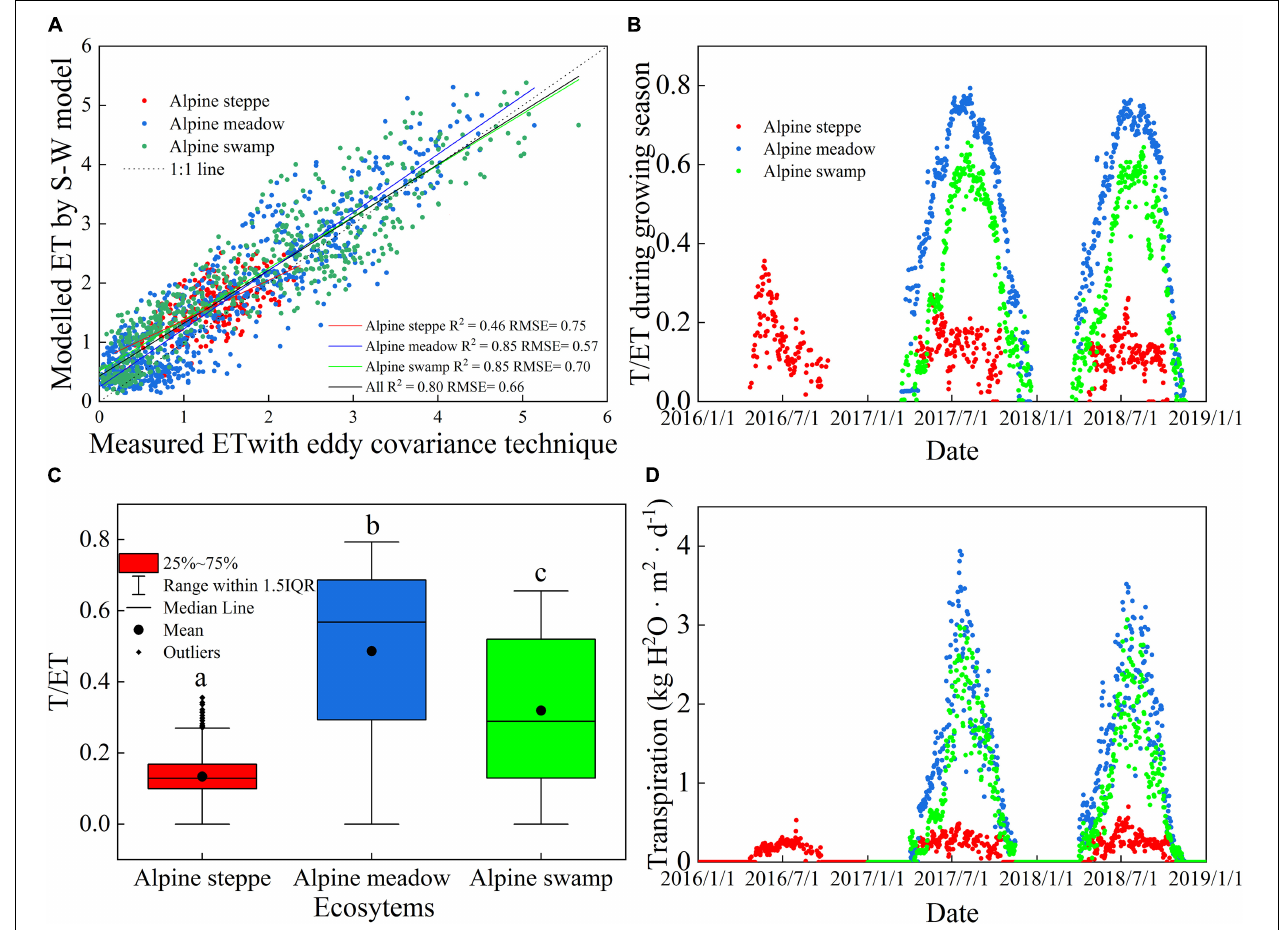
FIGURE 4 | Comparison of (A) measured and modeled daily ET, (B) daily time series of modeled ratio of transpiration to ET (transpiration [T]/ET), (C) the range of daily T/ET, and (D) T at the three sites. Different small letters indicate significant differences ( P <